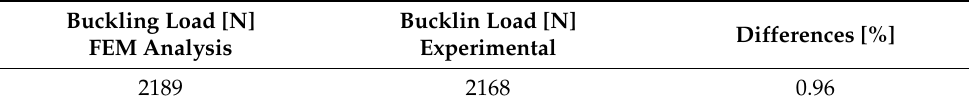
Figure 3. ( a ) Form of buckling, ( b ) form of post-critical deformation. Table 2. Comparison of buckling load